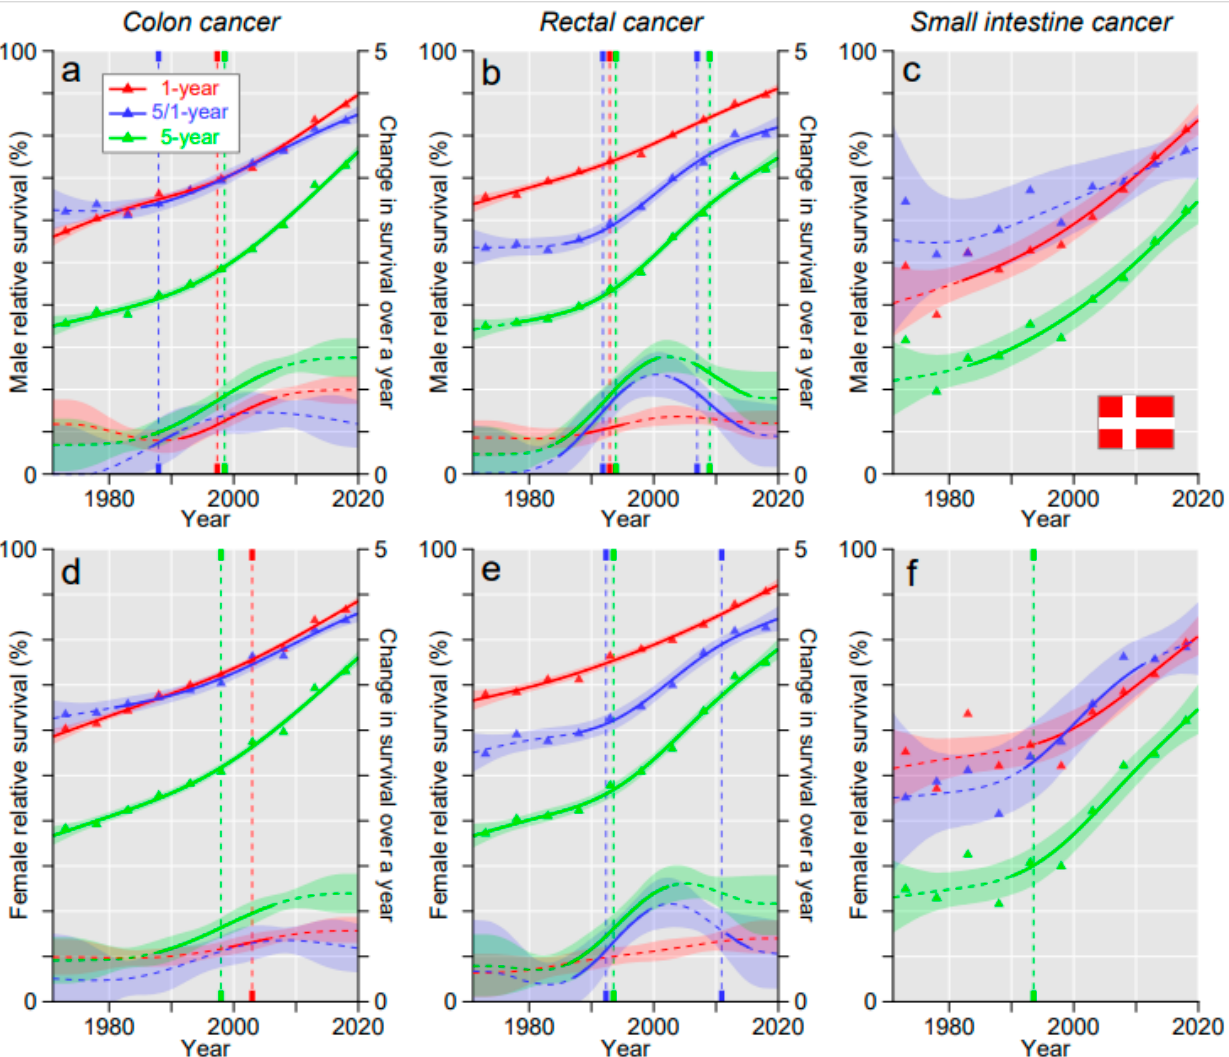
Figure 1. Relative 1- , 5/1- and 5-year survival in Danish men ( a – c ) and women ( d – f ) in colon ( a , d ), rectal ( b , e ) and small intestinal cancers ( c , f ). The vertical lines show significant breakpoints in survival trends and bottom curves show estimated annual changes in survival. The solid lines in survival curves and annual change curve indicate a plausible trend (see Methods). All curves are color coded (see the insert).